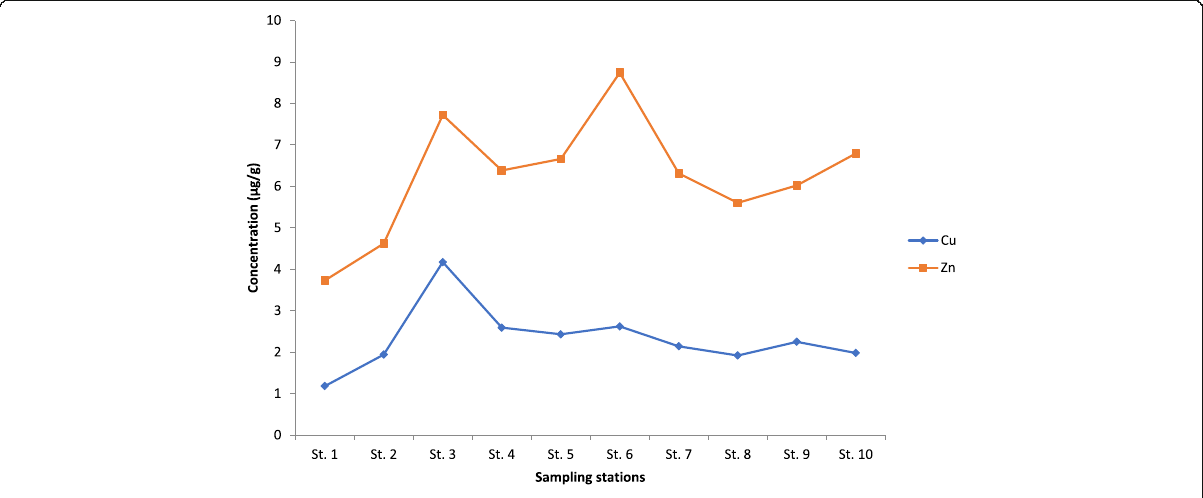
Fig. 3 Concentrations of Cu and Zn in M. tuberculata of River Osun, Osogbo, Nigeria (June 2015 – March 2016)